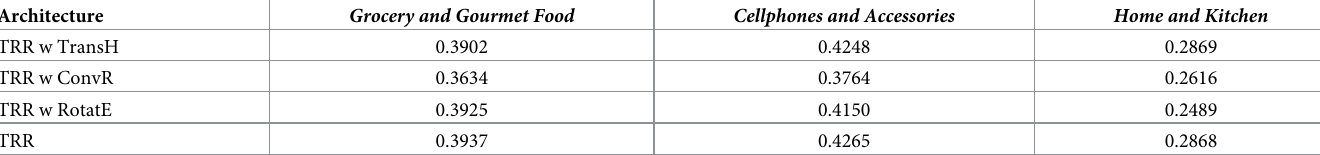
Table 3. The impact of four different training methods for knowledge graph embedding (NDCG@5). Architecture